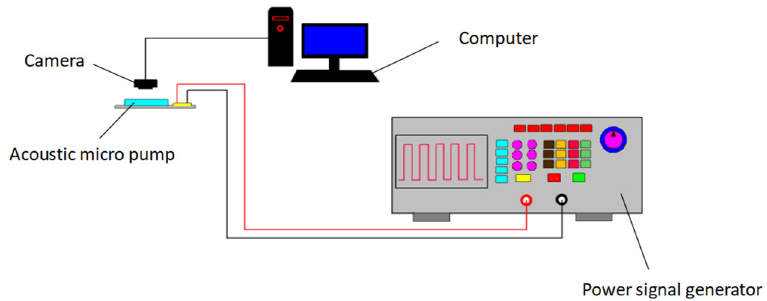
Figure 6. Schematic diagram of experimental test system.